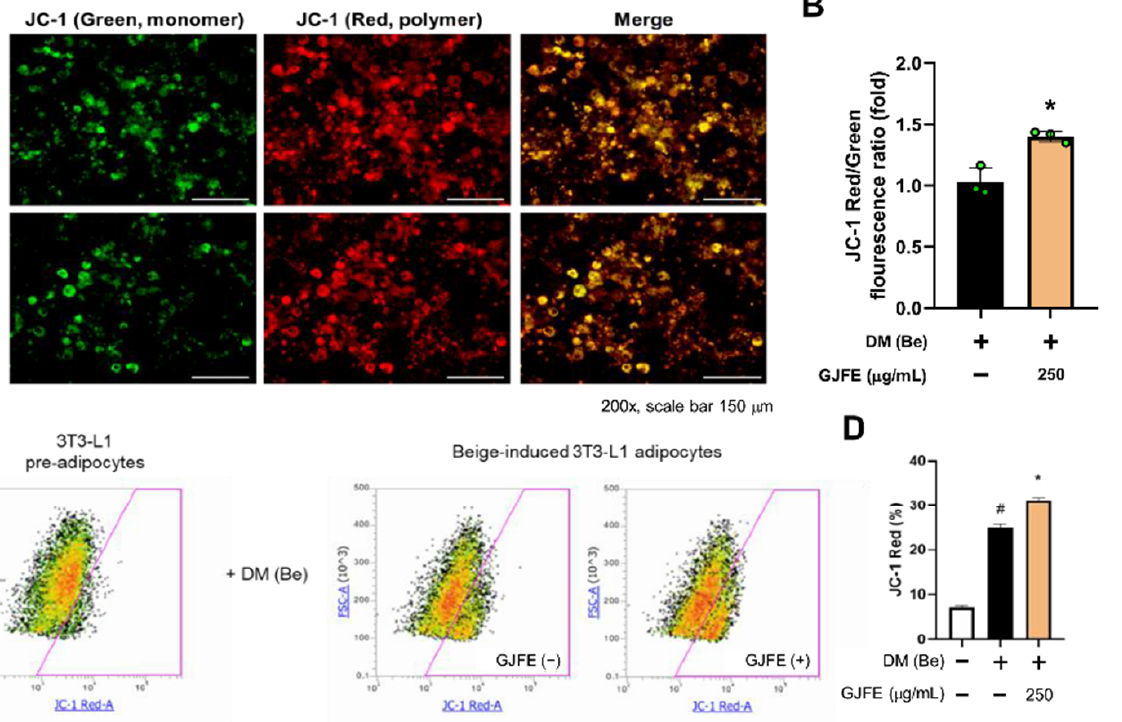
Figure 5. Effect of GJFE on mitochondrial activation in beige-induced 3T3-L1 cells. Mitochondrial membrane potential was measured by JC-1 staining in beige-induced 3T3-L1 cells treated with GJFE (250 μg/mL) by ( A , B ) immunofluorescence staining and ( C , D ) flow cytometry. ( E ) Protein level of CPT1β was analyzed by Western blot analysis. ( F ) Protein levels of TOM20 (red), PDK4 (green), and DAPI (blue) were detected by immunofluorescence staining (magnification 400×, scale bar 75 μm). ( G , H ) Protein levels of OXPHOS complex were analyzed by Western blot analysis. β-actin was used